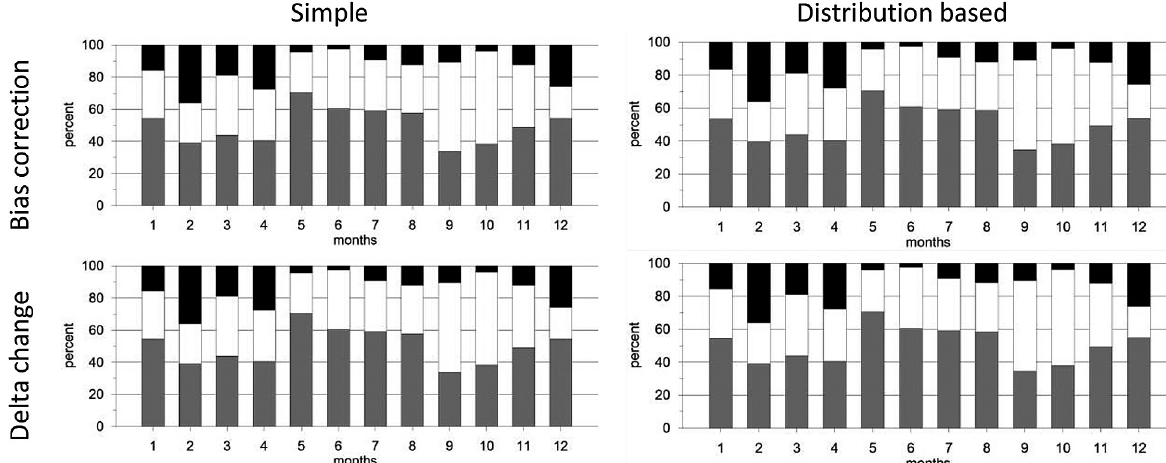
Fig. 2. Frequencies of improvements (grey), no change (white) and worsening (black) after corrections made by different methods for a mean. Bias correction methods in the upper raw and delta change methods in the lower raw, simple variants in the left column and distribution based variants in the right